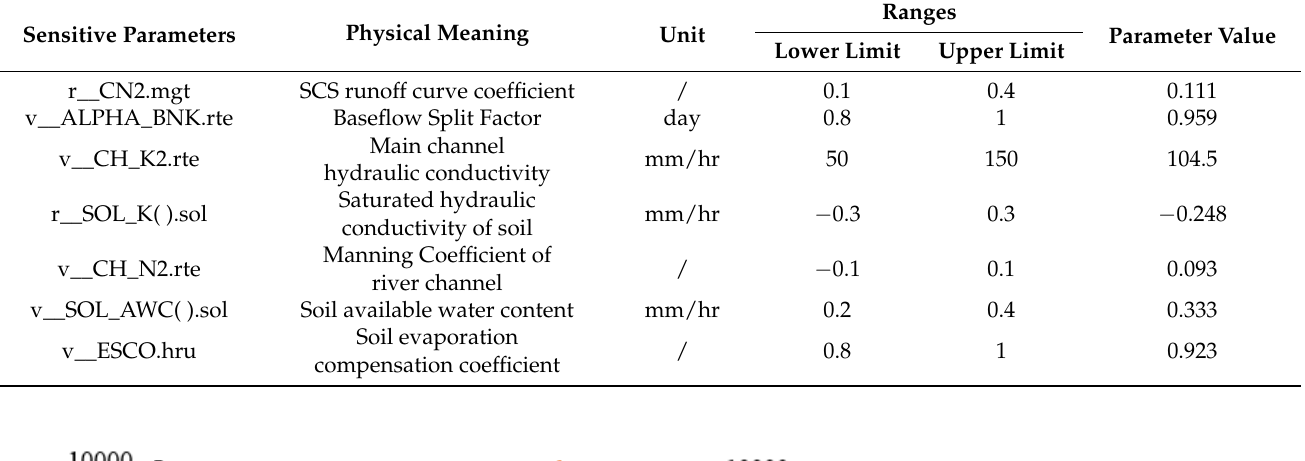
Table 3. Runoff sensitivity parameters of Shiquan hydrological station.